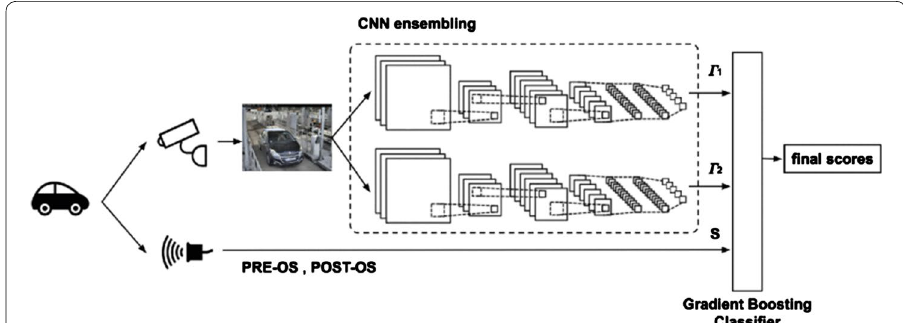
Fig. 7 Image from [90] depicting ensemble architecture of system for automatic vehicle detection; CNN and OS output are fed to CatBoost